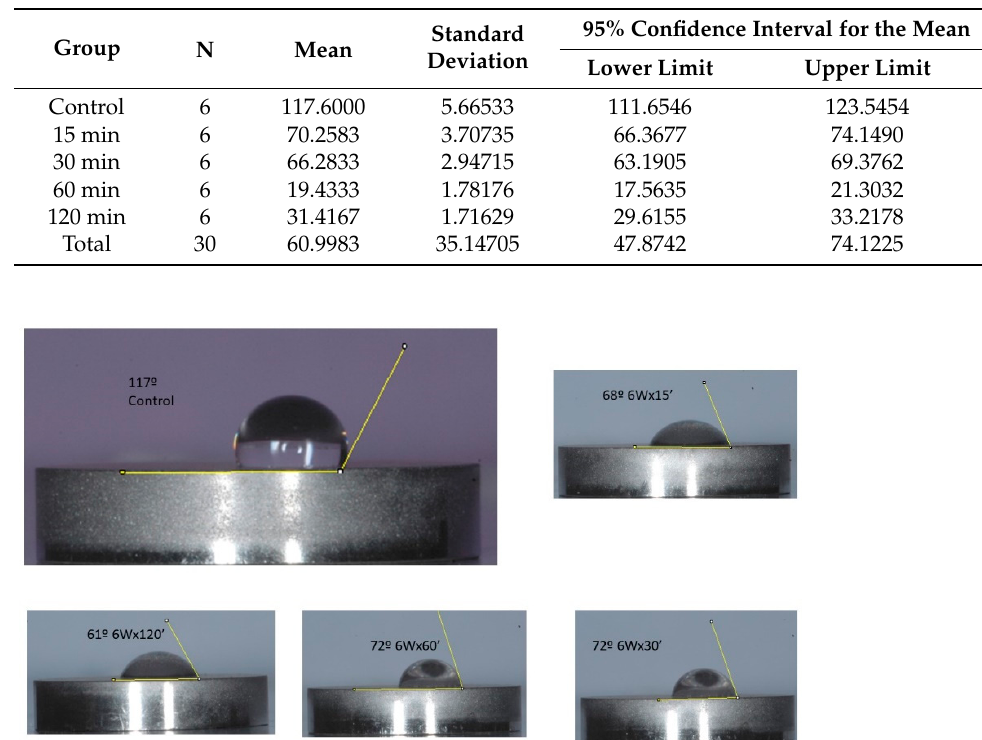
Table 2. Data obtained with the 85 W lamp.